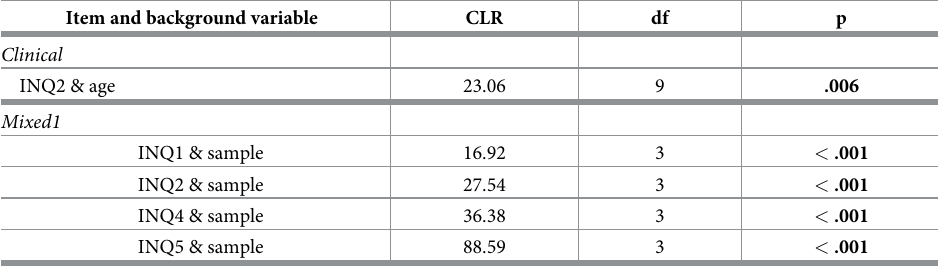
Table 3. Conditional likelihood ratio tests of DIF under the respective GLLRMs for the